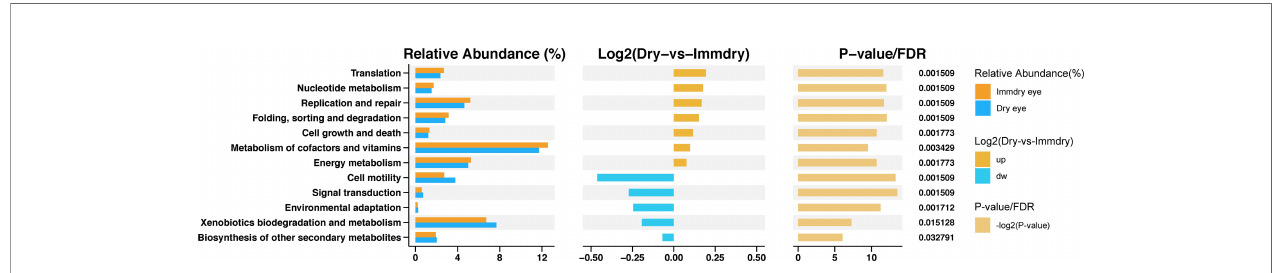
FIGURE 5 | Functional analysis of the predicted metagenomes. On the left is the relative abundance histogram for each group, in the middle is the log2 value of the mean relative abundance ratio of the same pathway in the two groups, and on the right is the − log2( p -value) and false discover rate (FDR) value obtained using the Wilcoxon test. If the p -value and FDR were less than 0.05, then there is a signi fi cant difference between the two